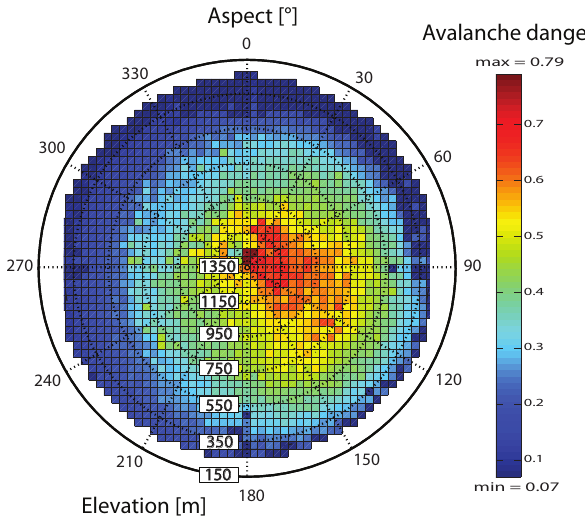
Fig. 4. Aspect/elevation diagram of the avalanche danger prediction for 15 February